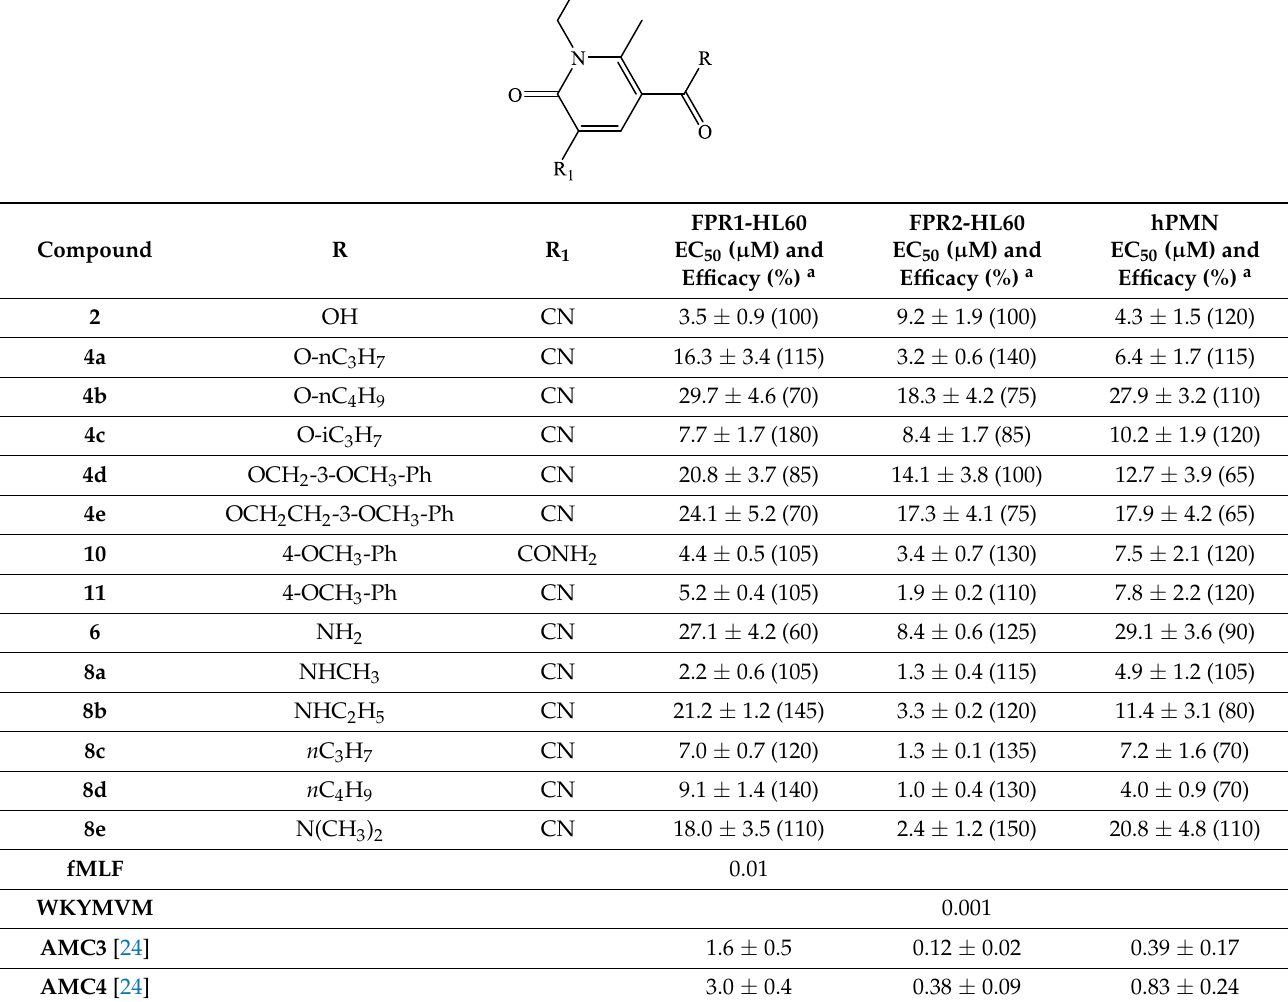
a EC 50 values represent the mean of three independent experiments and were determined by nonlinear regression analysis of the concentration-response curves (5–6 points) generated using GraphPad Prism 9 with 95% confidential interval ( p <